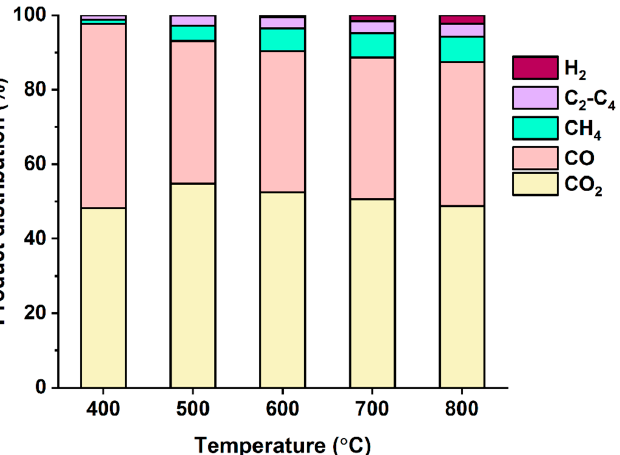
Figure 2. Product distribution of the gas phase pyrolysate made from DJW without Na 2 CO 3 as a function of pyrolysis temperature. Average values of triplicate are reported with and standard deviations of the average values of 3–4%.